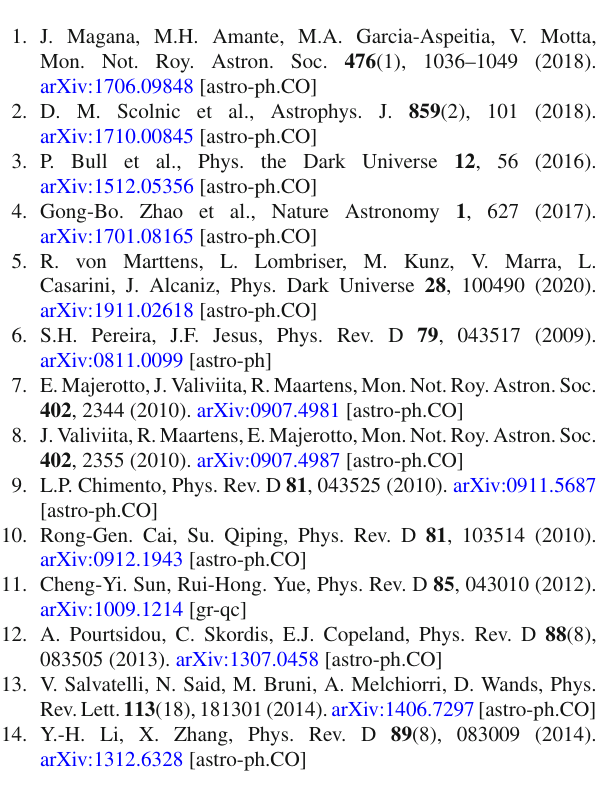
methods which are independent from the dynamics can be used, like non-parametric methods, like Gaussian Processes, Principal Component Analysis (PCA), Neural Networks